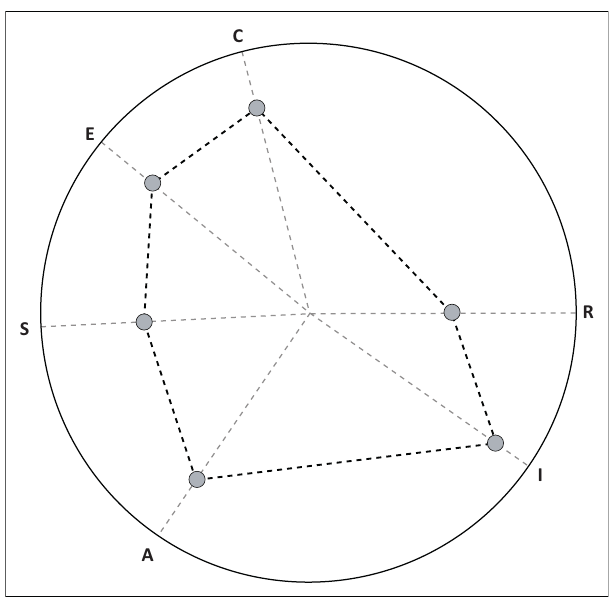
FIGURE 1: RIASEC angular locations and communality